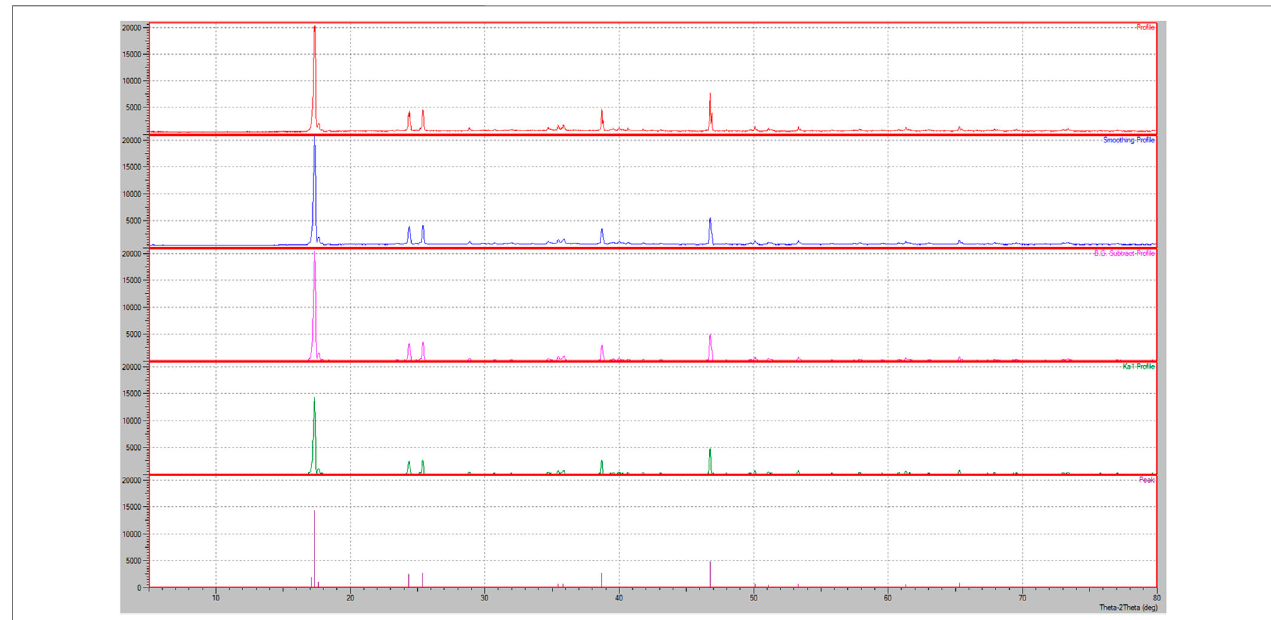
FIGURE 8 | Azurite sample